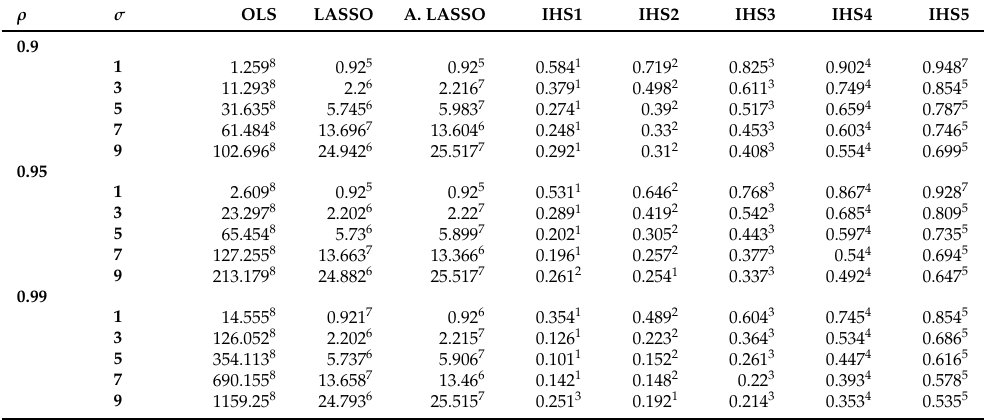
Table 4. Estimated MSEs for n = 50 and p = 8 (superscript represents ranking).